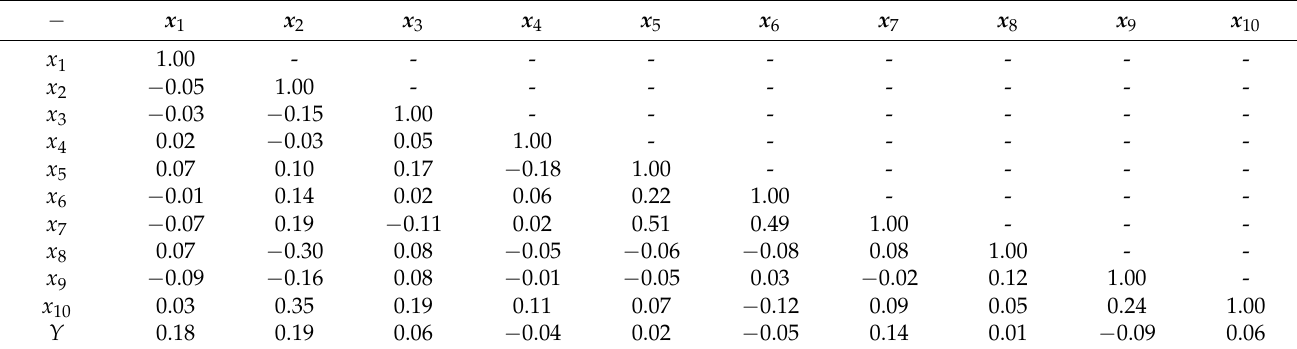
Table 2. Partial correlation analysis of process